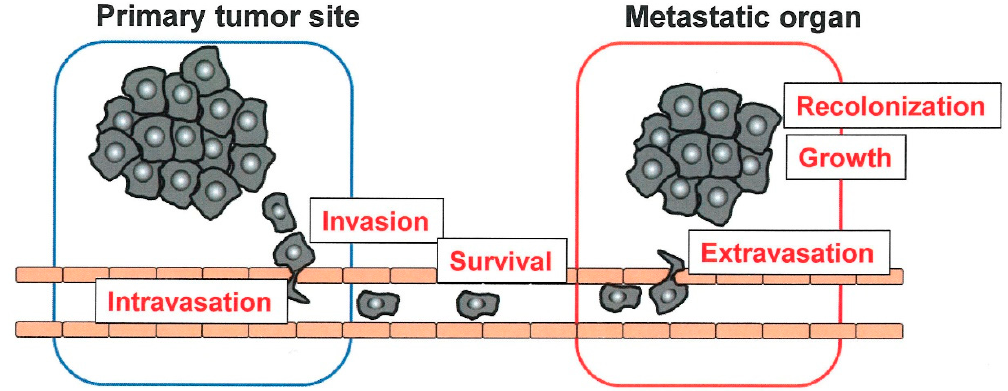
Figure 1. Multiple steps of metastasis. Tumor grows at primary site and invades the surrounding tissues to intravasate into circulation. Tumor cells, which survive in circulation, extravasate and recolonize a target organ to grow there.